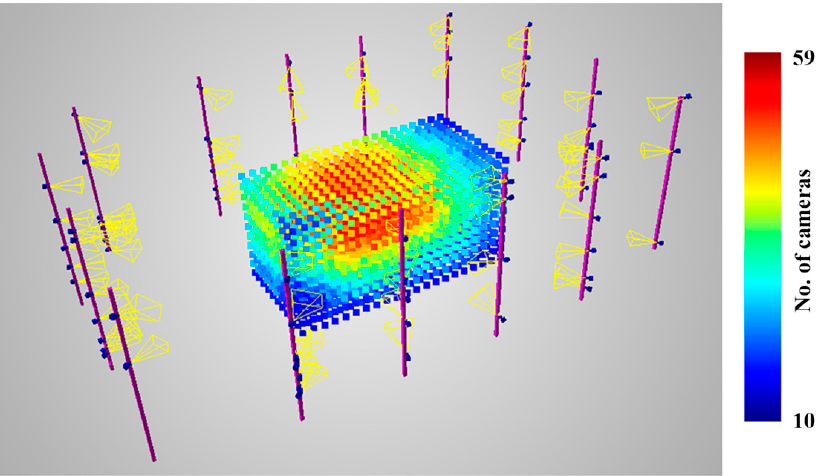
Figure 7. An example scene with camera setup and discretised measurement volume with the number of observing cameras presented in the colour scale.